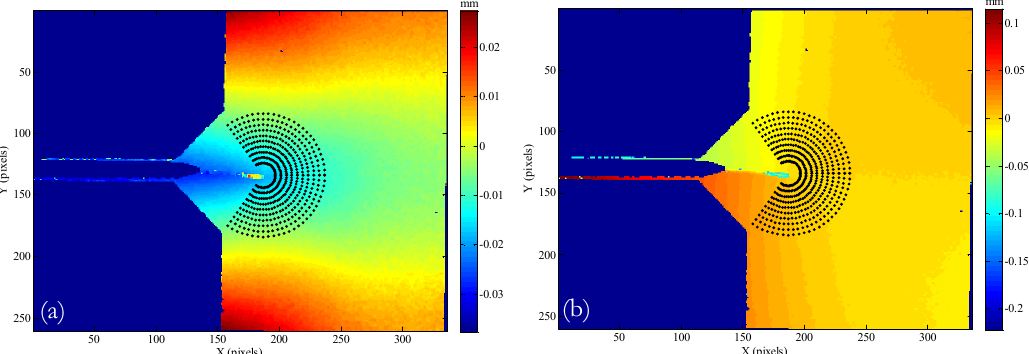
Figure 3: Horizontal (a) and vertical (b) displacement fields measured for a 34.10 mm and a load level of 600